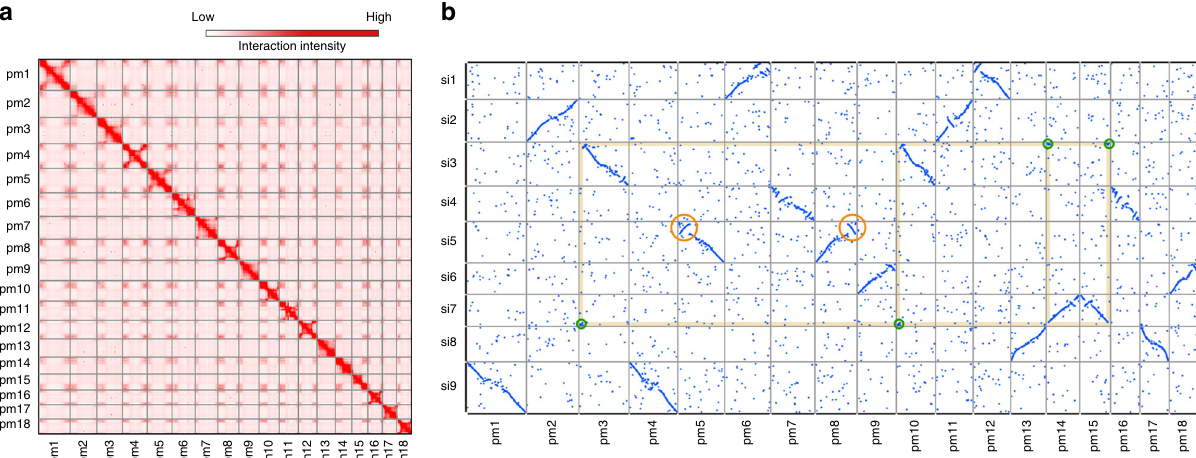
Fig. 1 The Hi-C assisted assembly of Longmi4 pseudomolecules. a Heatmap showing Hi-C interactions under the resolution of 200 kb, and the anti- diagonal pattern for the intrachromosomal interactions may re fl ect the Rabl con fi guration of chromatins. b Genome comparison between broomcorn millet (pm1 – pm18) and foxtail millet (si1 – si9). Each dot represented a homologous sequence reported by Mummer, and the two orange circles referred to two intrachromosomal inversions. The green circles represented the quartet of interchromosomal exchanges that may be happened before tetraploidization. Source Data of Fig. 1b are provided as a Source Data fi